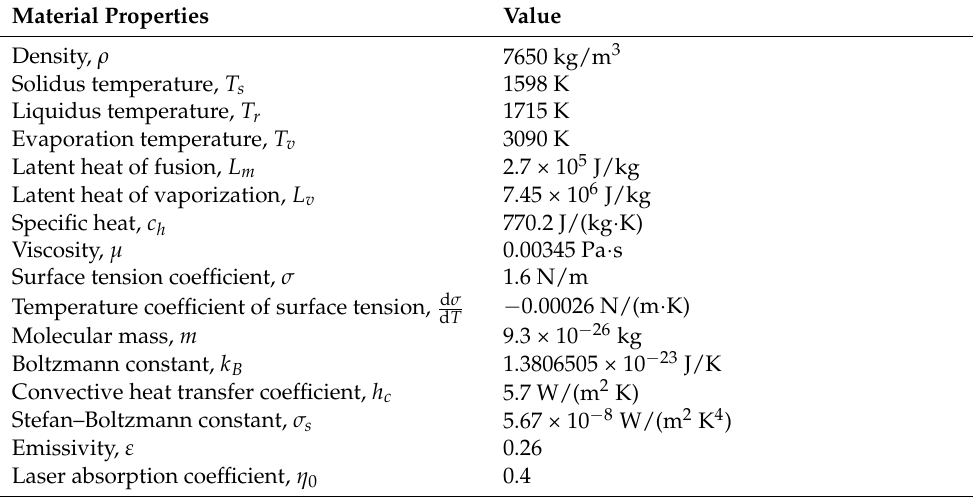
Table 1. Physical properties of 316L stainless steel [6,42–44].